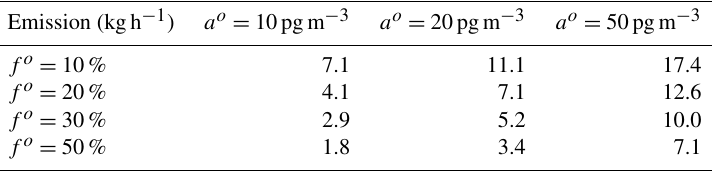
Table 2. Emission strength of release 2 that minimizes F for different observational errors, defined as (cid:15) = f o × c o + a o . Concentration is used as the metric variable.